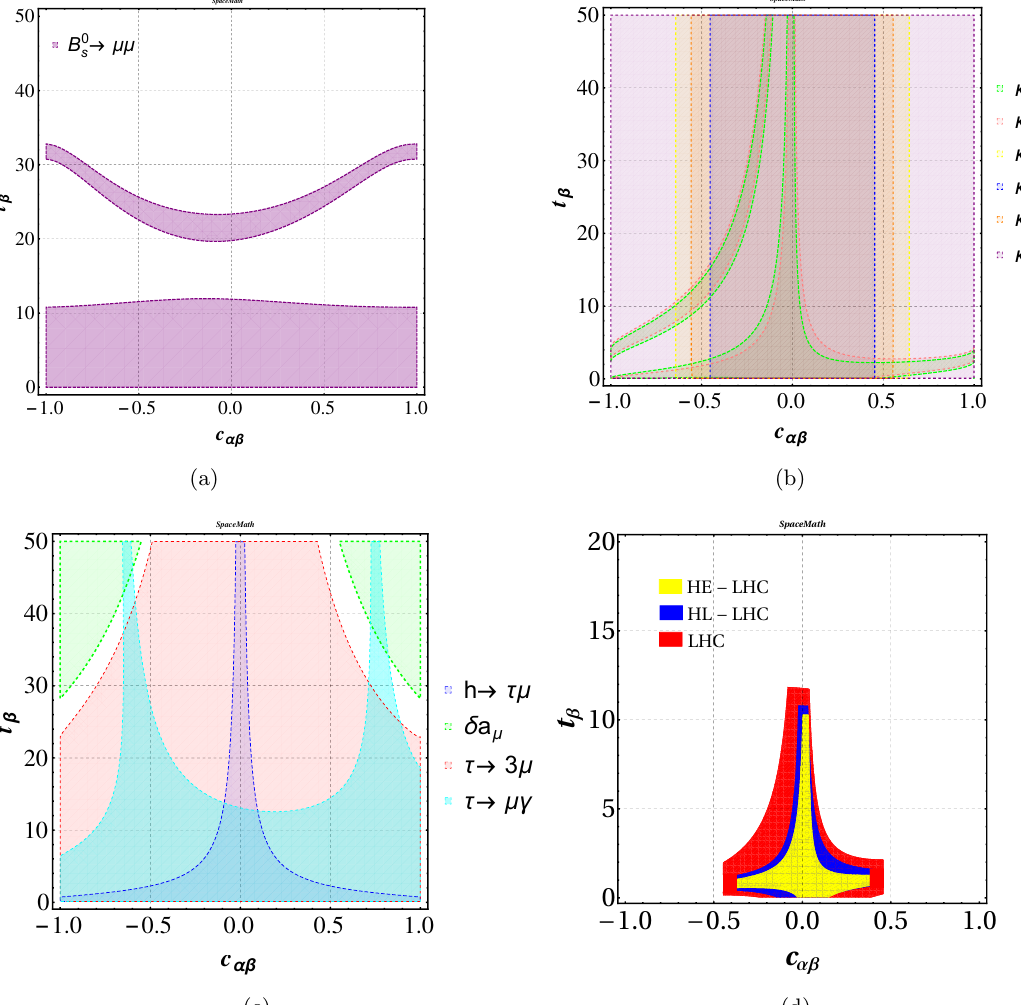
0 (cid:22) + (cid:22) (cid:0) , (cid:11)(cid:12) - t (cid:12) : (a) B s !